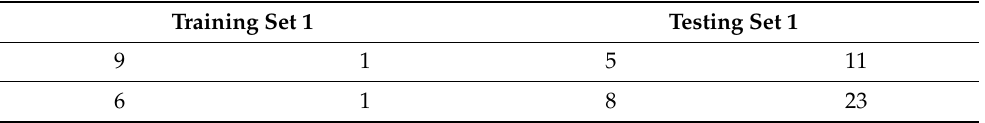
Table 7. LVSI Confusion matrix of Training sets and Testing sets: in the upper left rectangle the true high risk is noted, in the upper right rectangle the false high risk is noted, in the lower left rectangle the false low risk is noted, in the lower right rectangle the true low risk is